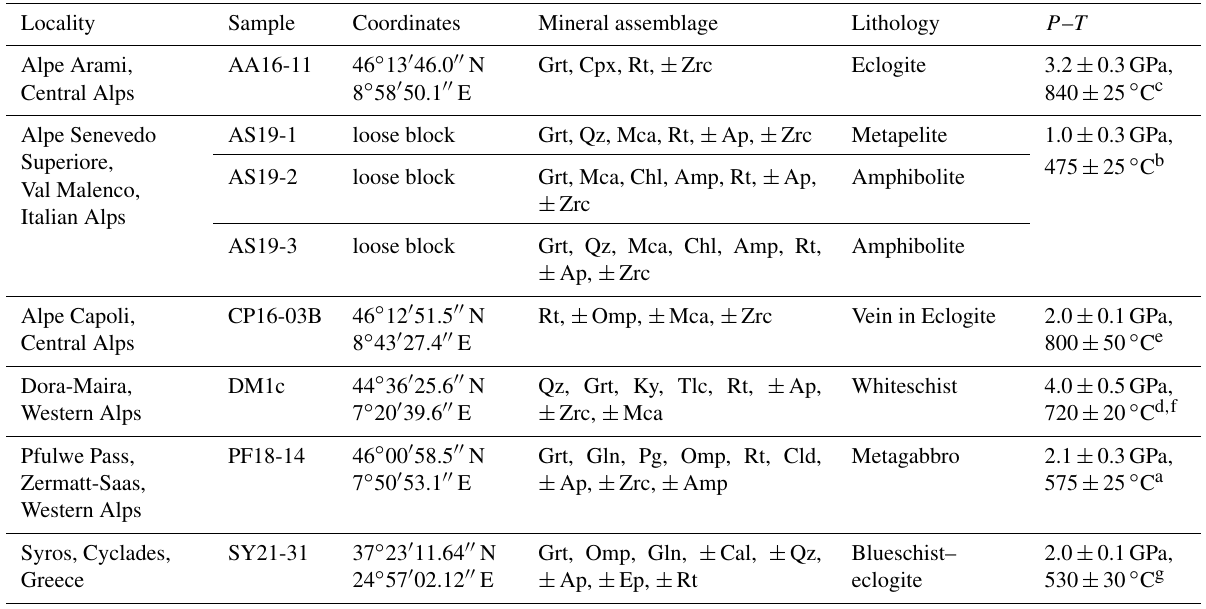
Table 2. Samples with localities, main mineral assemblage, and P – T conditions. Mineral abbreviations after Warr (2021). Locality Sample Coordinates Mineral assemblage Lithology P –